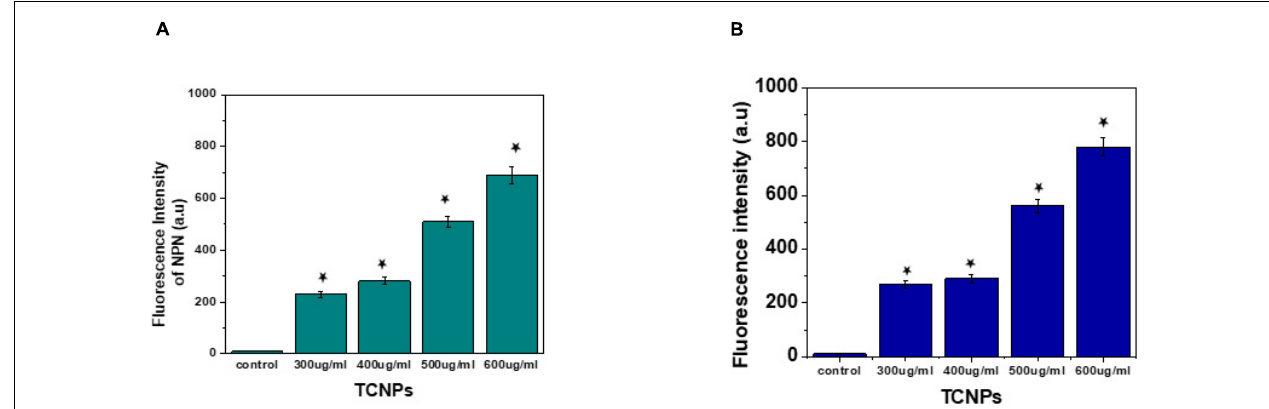
FIGURE 5 | Mode of action by membrane permeability assays. (A) NPN assay showing increased fluorescence intensity at sub lethal concentration of TCNPs against Xcc cells. (B) Pl assay showing increased fluorescence intensity at sub lethal concentration of TCNPs against Xcc cells denoting membrane damage. Values are mean ± SD of three independent experiments, each performed in triplicate and considered statistically significant when * p < 0.05.